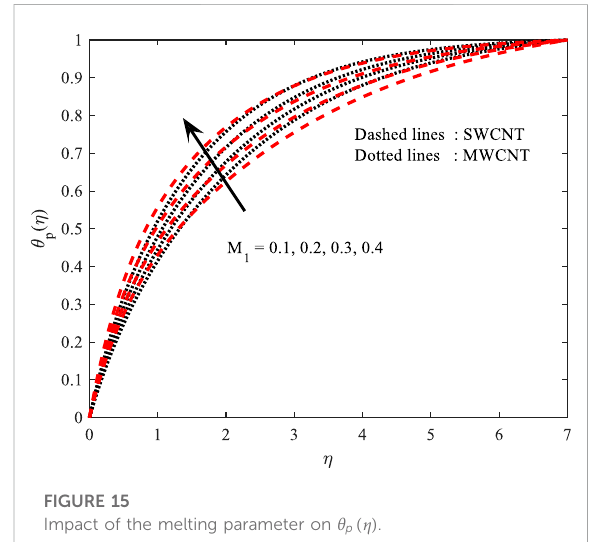
FIGURE 16 Impact of magnetic fi eld strength on θ ( η )